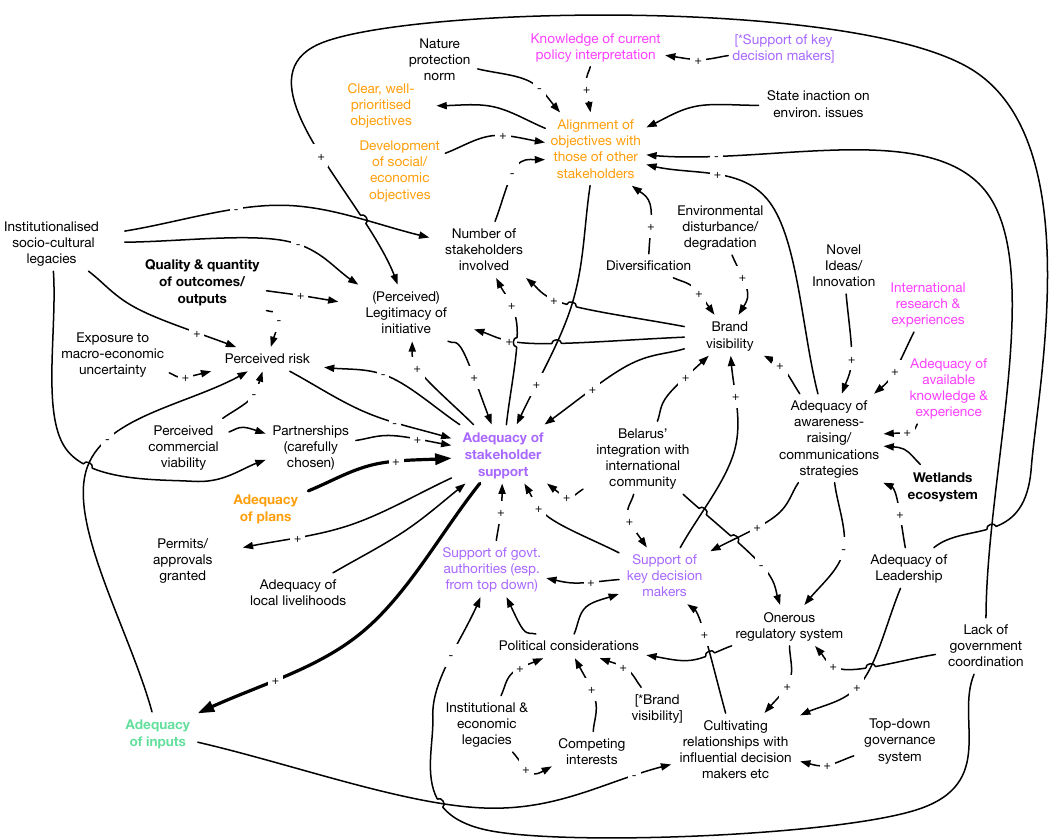
Figure 6 (from main paper). Sub-model unpacking causal dynamics influencing Adequacy of stakeholder support, which is partially disaggregated in this diagram to clarify key dynamics relating to the support of two important stakeholder types, government authorities and key decision-makers. Whilst other drivers of support, e.g. brand visibility, or legitimacy of initiative, also influence these sub-concepts, these relationships are not explicitly represented here, for the sake of diagrammatic clarity and to avoid